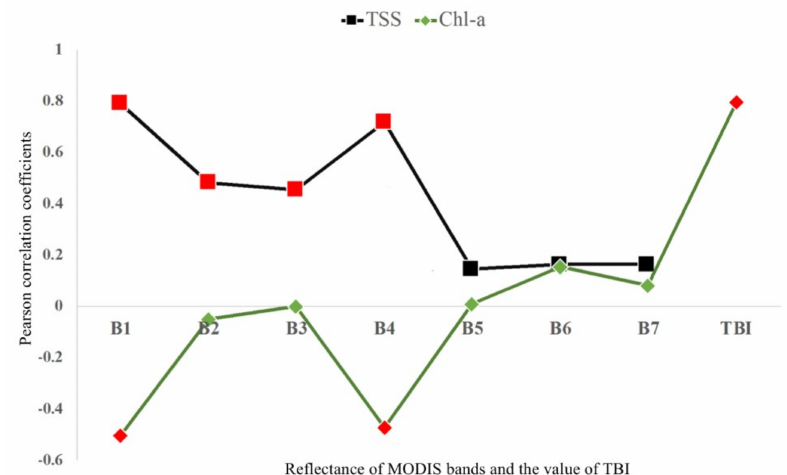
Figure 3. Pearson correlation coefficients between total suspended solids (TSS) and chlorophyll-a (Chla) concentrations versus MODIS 1b bands. The red dot represents the P value obtained from the correlation calculation, and is less than